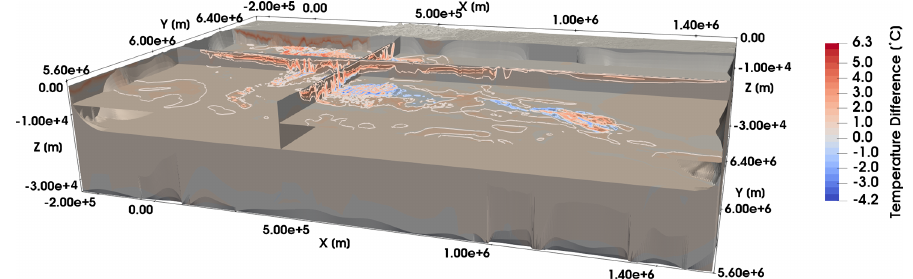
Figure 13. Difference in the temperature distribution for the upper 30km between the state at 22.8ka and the initial condition for the transient simulation considering a simulation time of